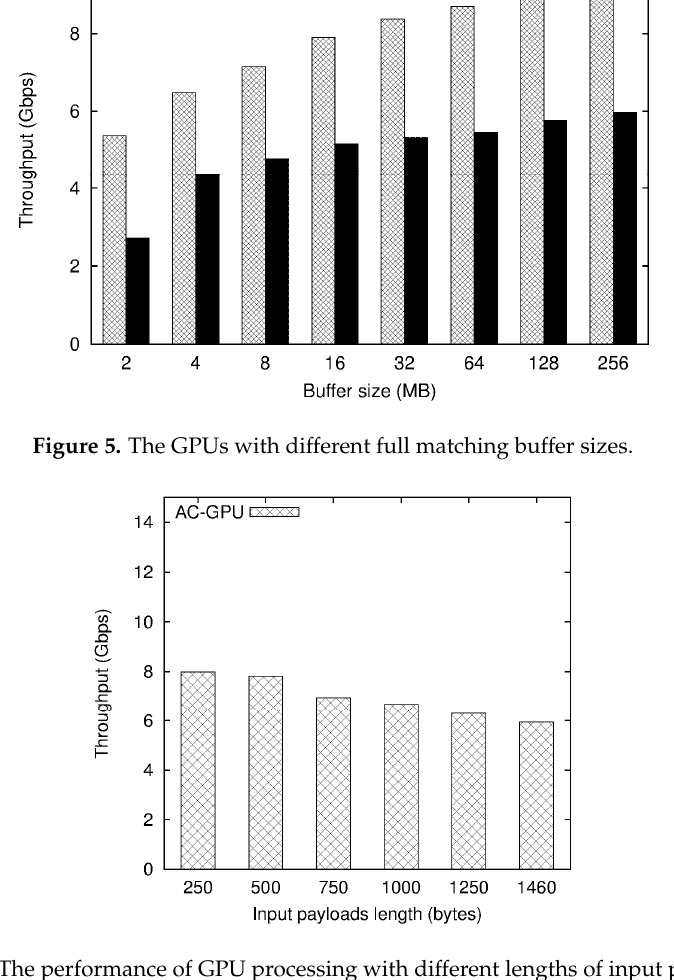
Figure 6. The performance of GPU processing with different lengths of input payloads.